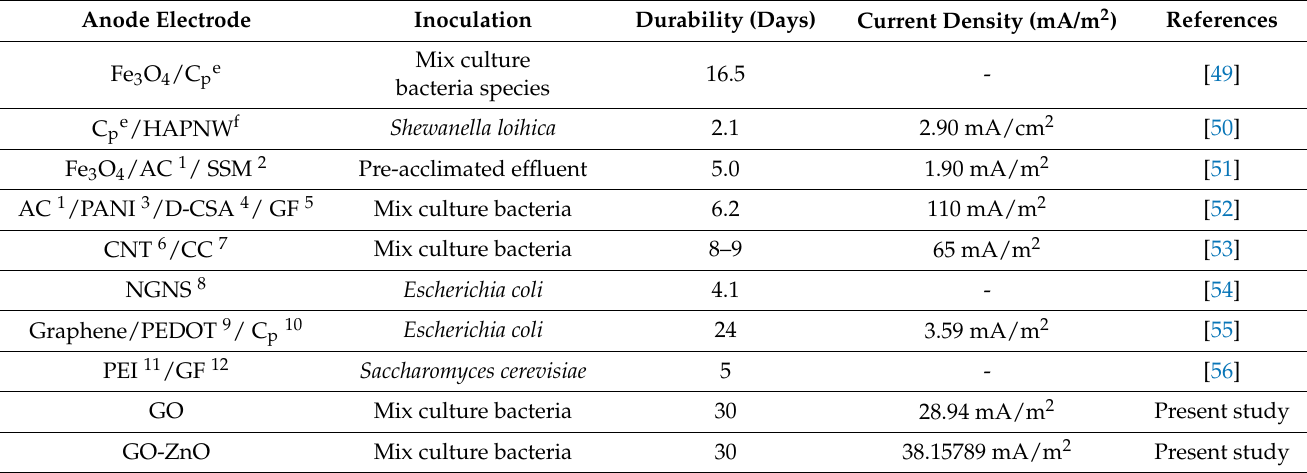
Table 3. A profile comparison of prepared anodes with previous